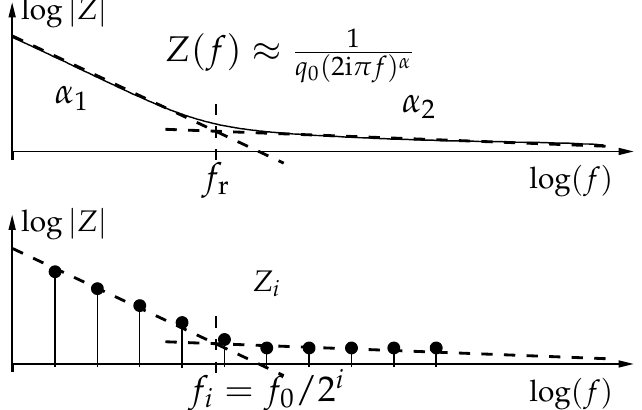
Figure 2. Bioimpedance modeling by constant phase elements ( CPE ). Two domains and the transition (relaxation) frequency are highlighted ( top ). Logarithmic sampling of the bioimpedance measurements for parameter estimation ( bottom ).